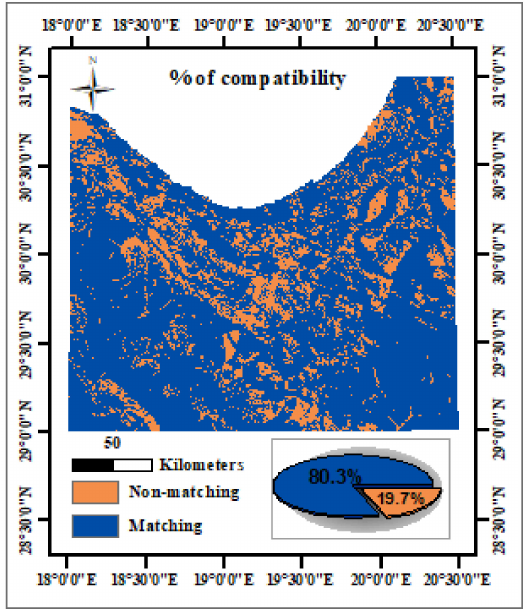
Figure 12. The comparison map of ROC and AHP methods and its percentages.